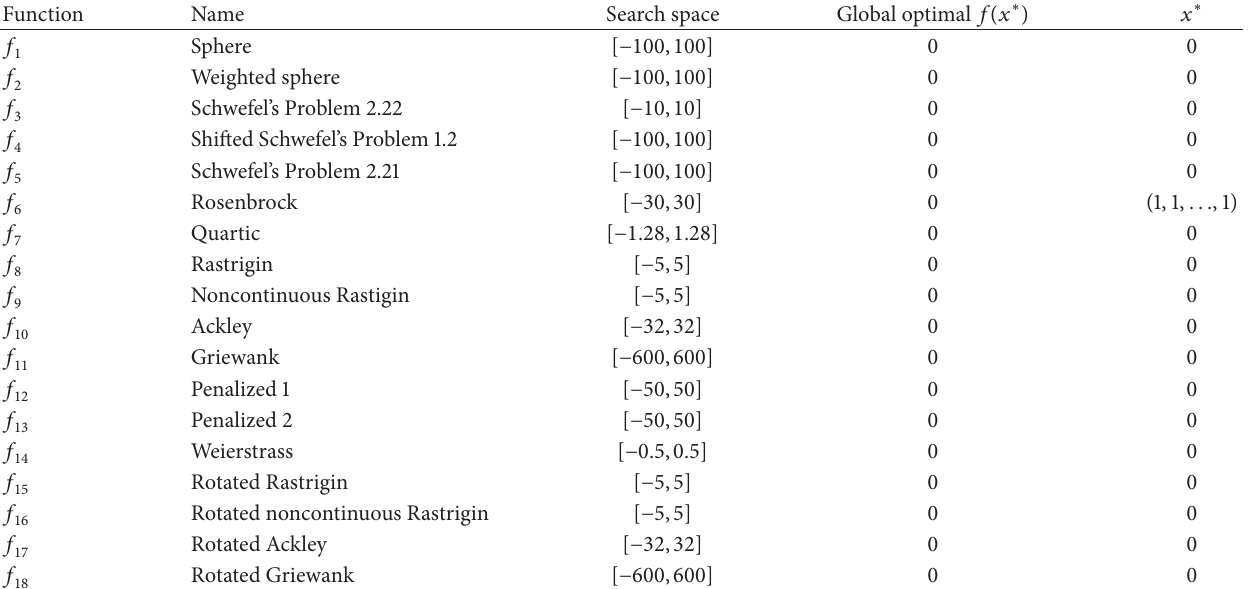
Table 1: Benchmark configurations.